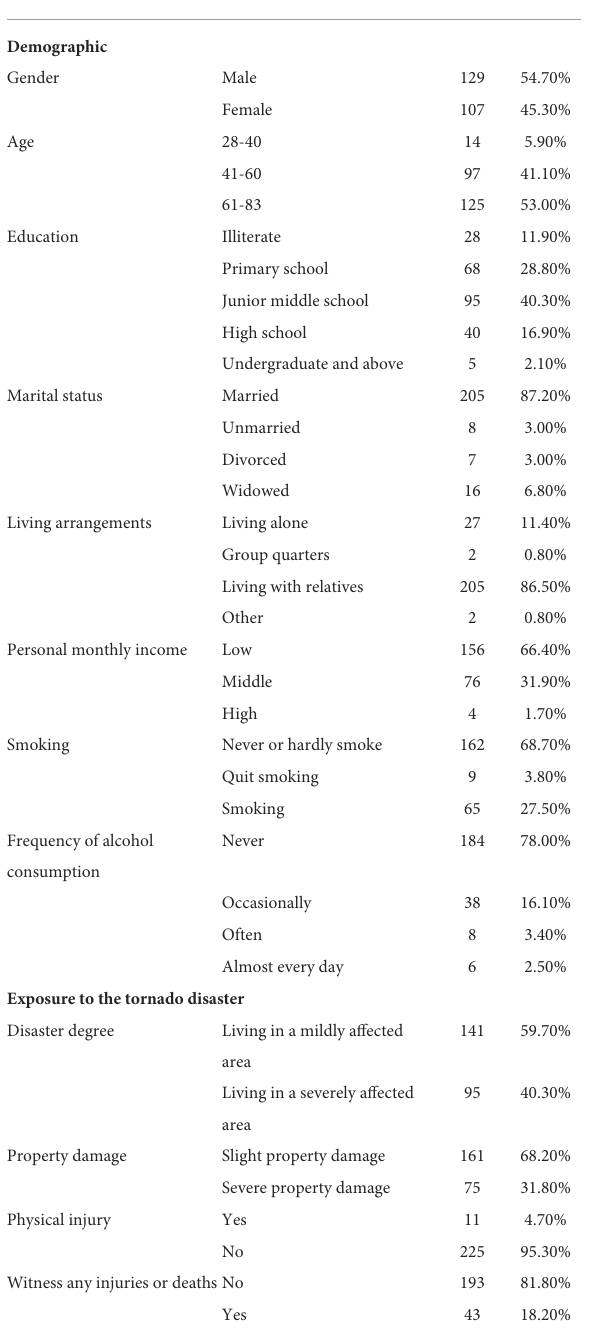
TABLE 1 Demographic information and characteristics of exposure to the tornado of rural residents who survived the tornado disaster. Factors n